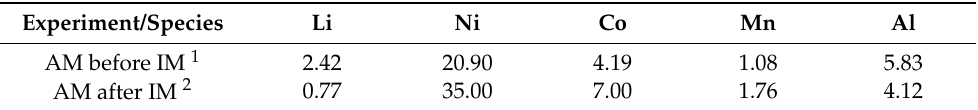
Table 6. Chemical composition of AM before and after the InduMelt experiment. (w/%). Experiment/Species